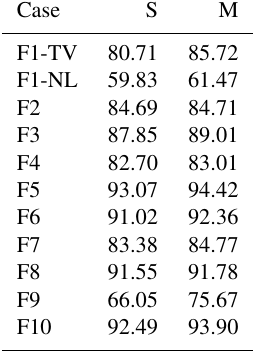
Table 3. Percentage of data points classified in the same cluster as F1 for the different feature sets (second column – S). In the third column (M), the two magnetosheath clusters just downstream of the bow shock, i.e., 1 and 4, are considered one. The data set used is the validation data set at time t 0 + 210min.